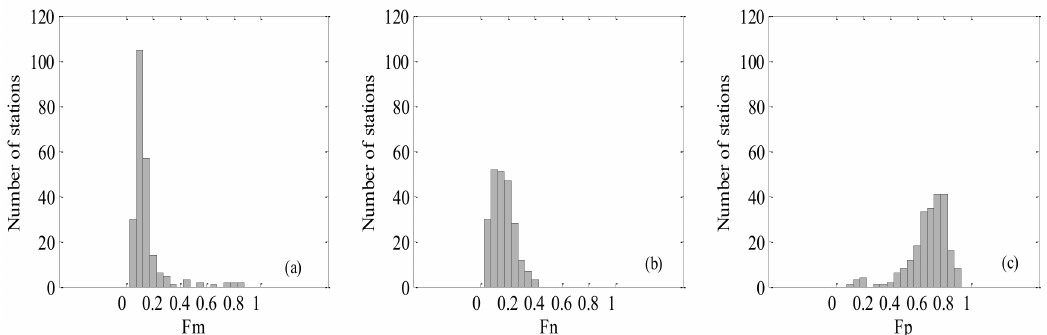
Figure 3. Histogram of the in situ HPLC data sets for the South China Sea (SCS).